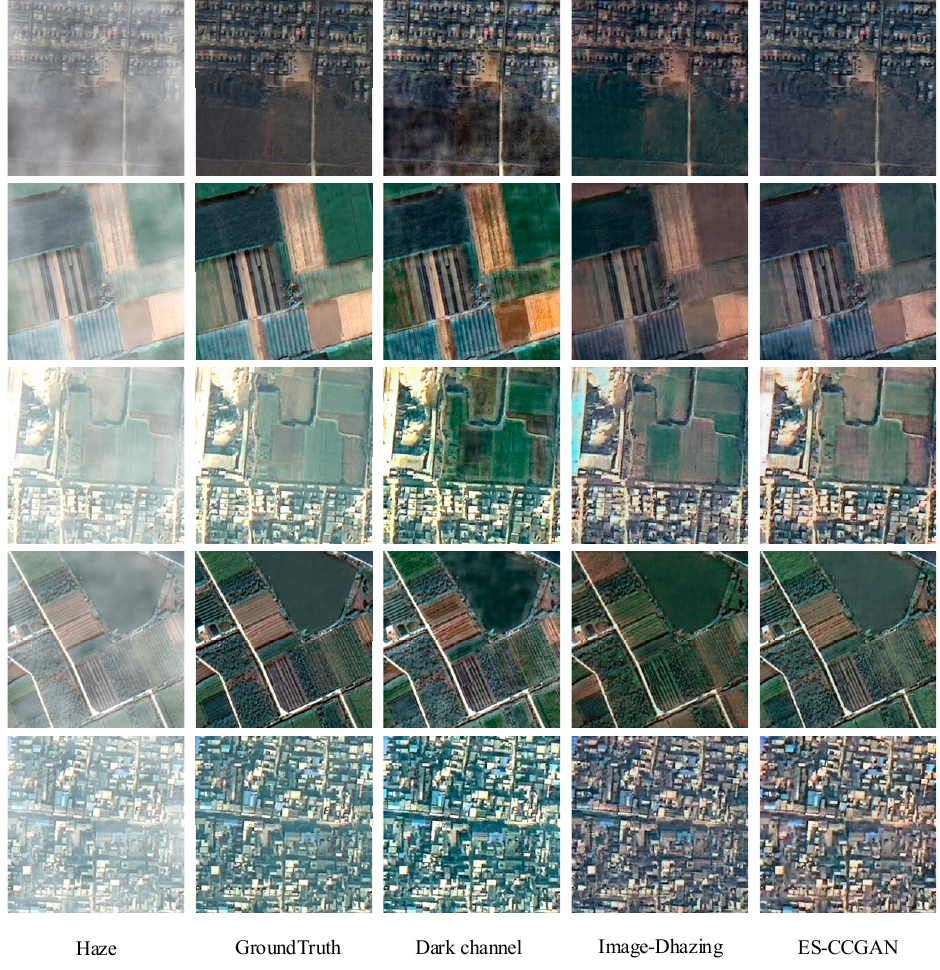
Figure 8. Dehazing results of several methods.